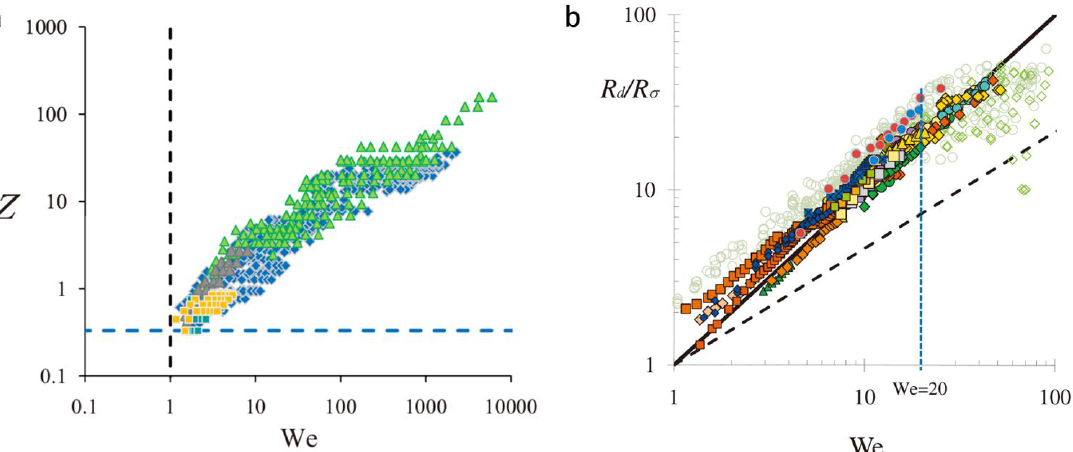
dius R d / R σ vs. We for both flow focusing and electrospray. The symbols signify different fluids. The solid line is consistent with Equation (1). Reproduced from [37], copyright 2009, American Physical Society.